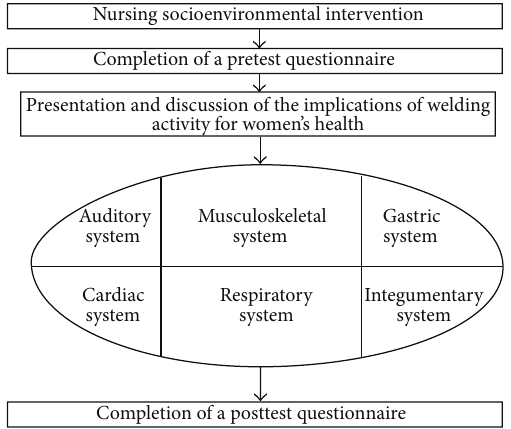
Figure 1: Steps of nursing socioenvironmental